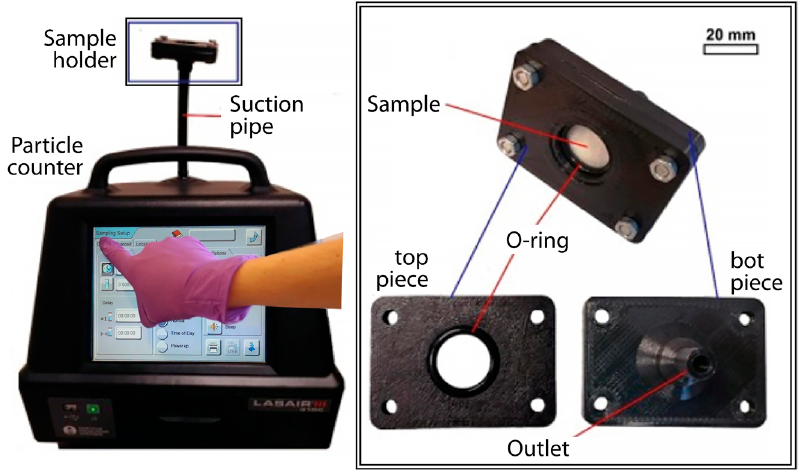
Figure 1. The setup of our particle-counting-based measurement system. The Lasair III 310C is a portable aerosol particle counter that is usually used to qualify clean-room laboratories in microelectronics or medicine production. It works with a laser- based counting method. The accessing particle in the device passes through laser light. A photodetector detects the redirected light and the loss of light, which determines the size of the obstructing particle. The particle counter distinguishes the counted particles according to the estimated sizes into 6 channels: 0.3–0.5 µ m, 0.5–1 µ m, 1–5 µ m, 5–10 µ m, 10–25 µ m, and >25 µ m. The volume flow rate of the particle counter was 30 L/min, which is approximately the average breathing flow of humans in comfortable